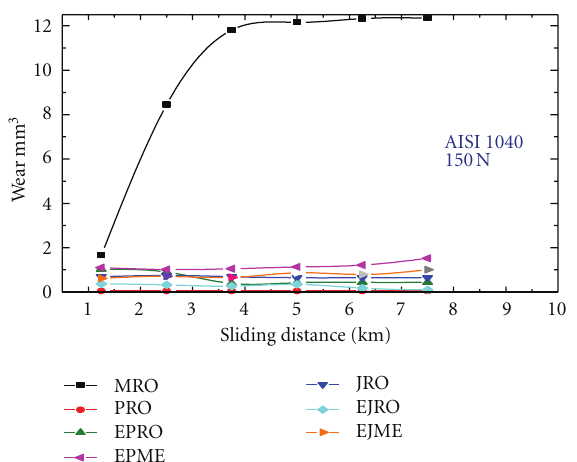
Figure 7: Variation of wear with sliding distance for 150 N.